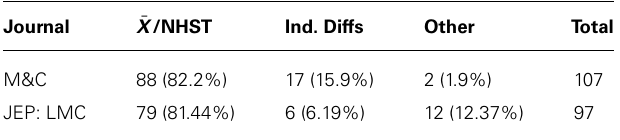
Table 2 | Number (%) of empirical articles in Memory & Cognition (2012) and Journal of Experimental Psychology: Learning, Memory, and Cognition (2012) classified according to main analysis type.